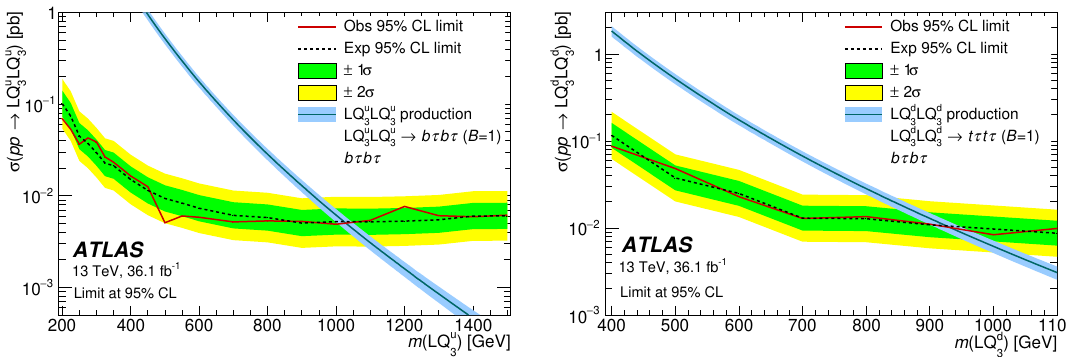
Figure 8 . Expected and observed 95% CL upper limits on the cross-section for up-type (left) and down-type (right) scalar leptoquark pair production with B = 1 as a function of leptoquark mass for the combined (cid:28) ‘ (cid:28) had and (cid:28) had (cid:28) had channels. The observed limit is shown as the solid line. The thickness of the theory curve represents the theoretical uncertainty from PDFs, renormalization and factorization scales, and the strong coupling constant (cid:11) s